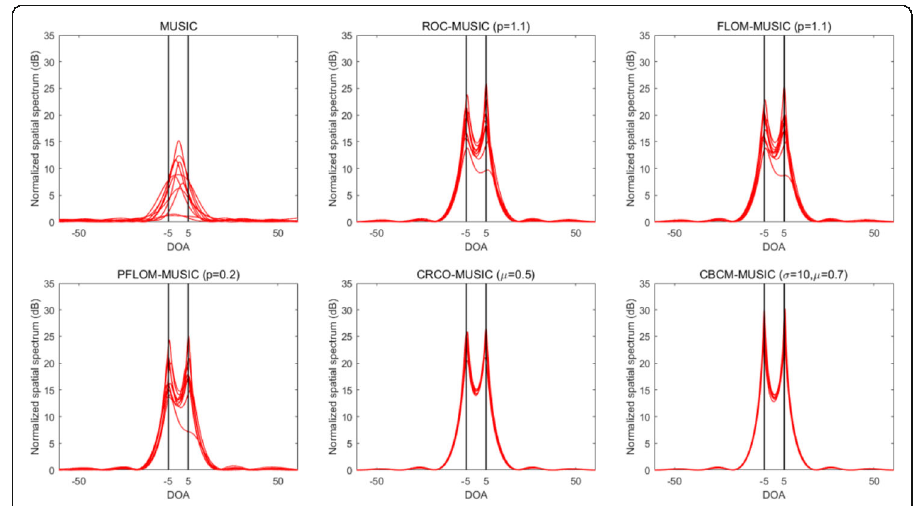
Fig. 12 The normalized spatial spectrum of the algorithms (black lines: true